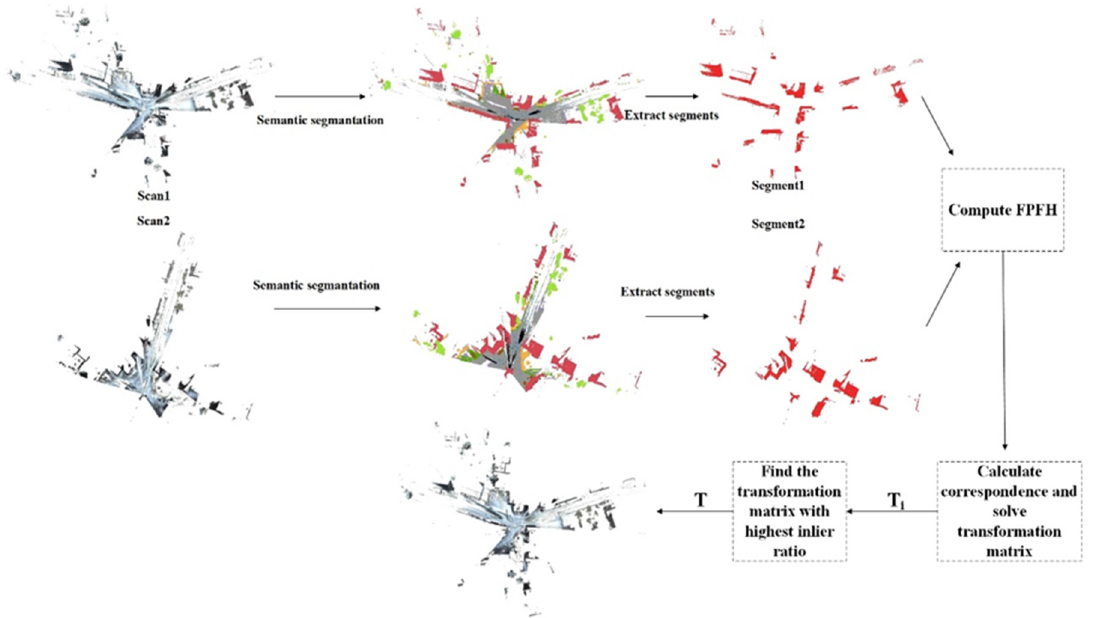
Figure 1. The over information flow of our method.